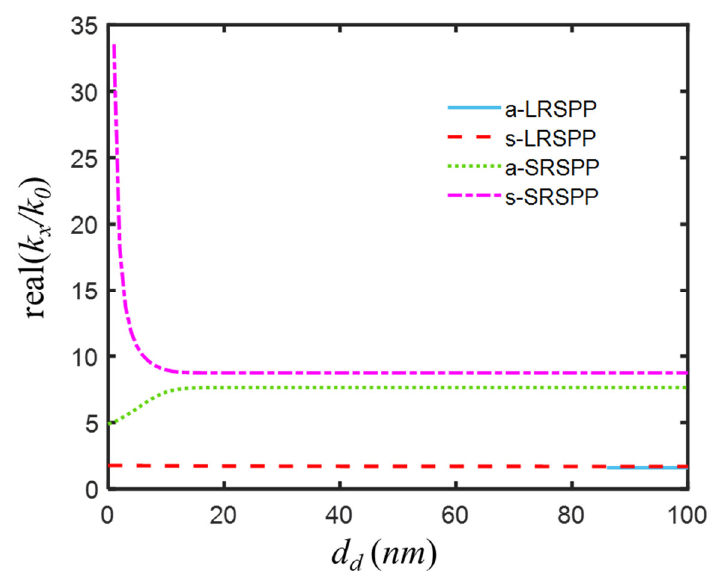
Figure 5. Real part of effective mode indices n ef f = k x / k 0 of a-LRSPP, s-LRSPP, a-SRSPP, and s-SRSPP of IMIMI waveguide for variant thickness of central dielectric layer d d from 100 nm to 0 nm, with d s 1 = d s 2 = 5 nm.